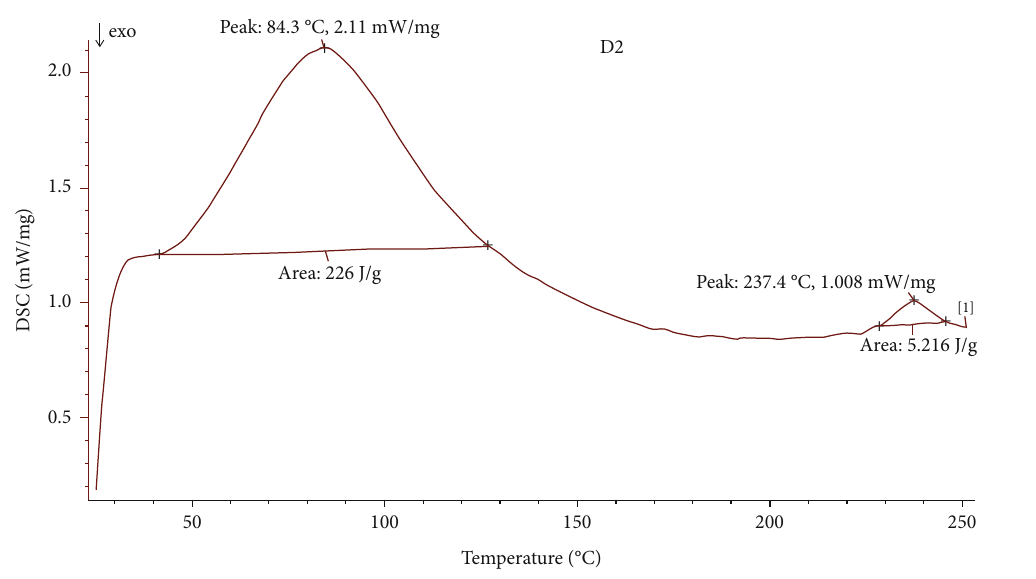
Figure 10: Dynamic scanning calorimetry for SA-Ag-NP-incorporated chitosan